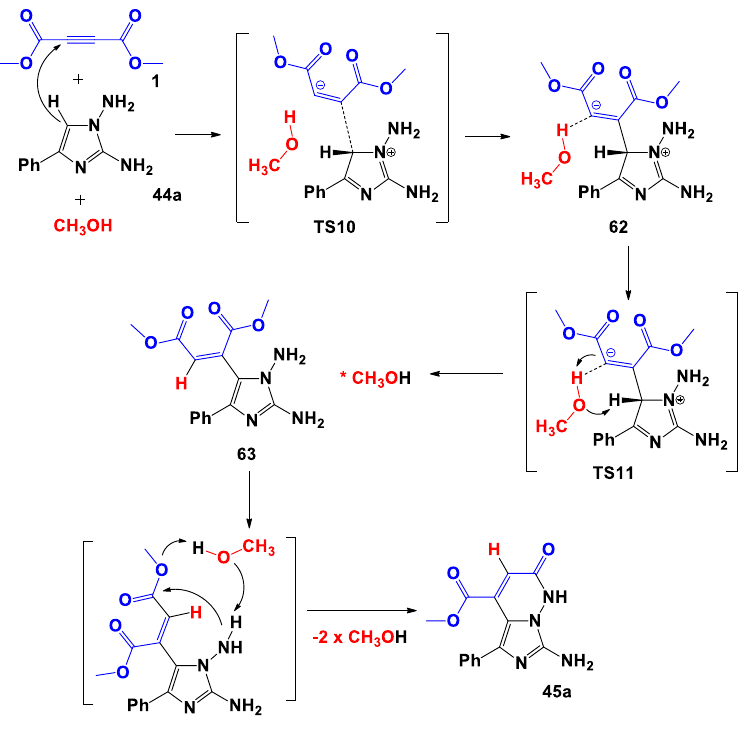
Scheme 13. Proposed trimolecular formation mechanism of 45а .